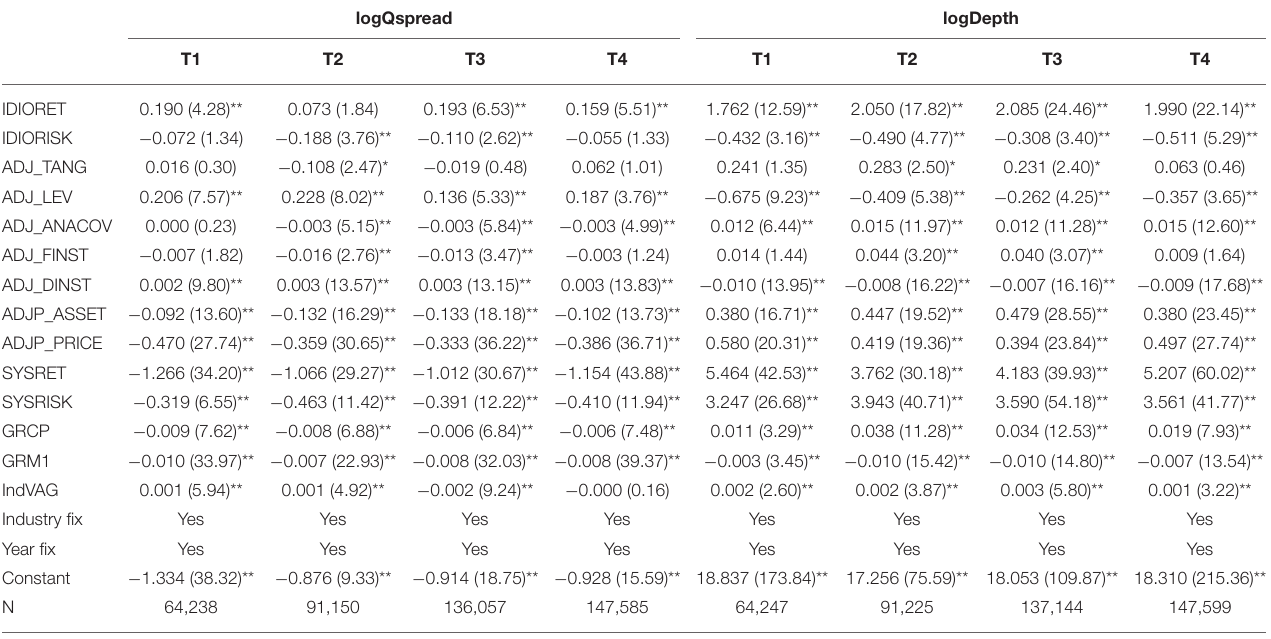
TABLE 8 | One-month-forward prediction of quoted relative bid–ask price spread and trading depth over four